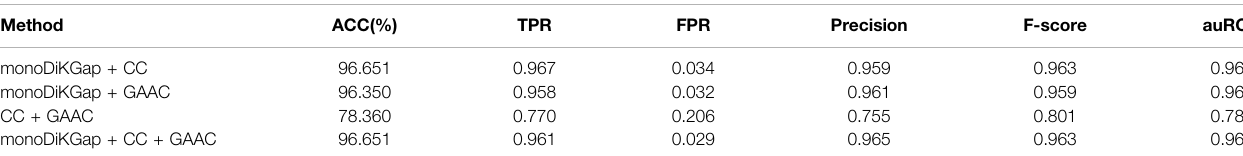
TABLE 2 | Performance comparison of different feature combinations under SVM classi fi ers. Method